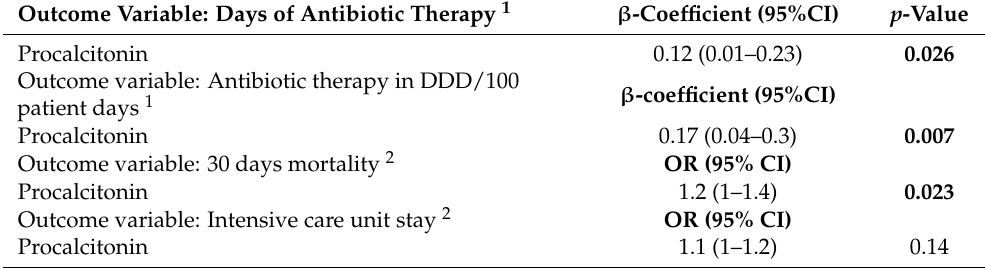
Table 2. The association of procalcitonin with the outcomes: antibiotic use, mortality, and a stay in the